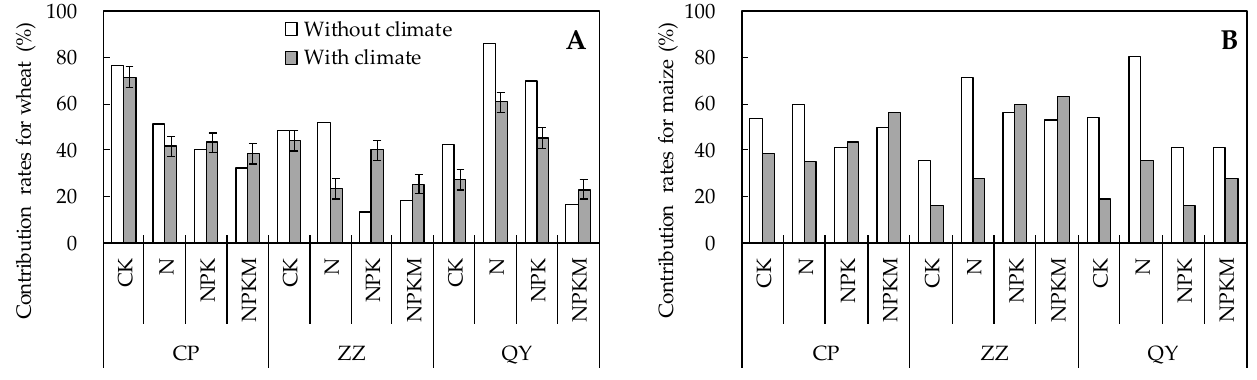
Figure 2. The contribution rates of soil property to the wheat ( A ) and maize ( B ) yields.